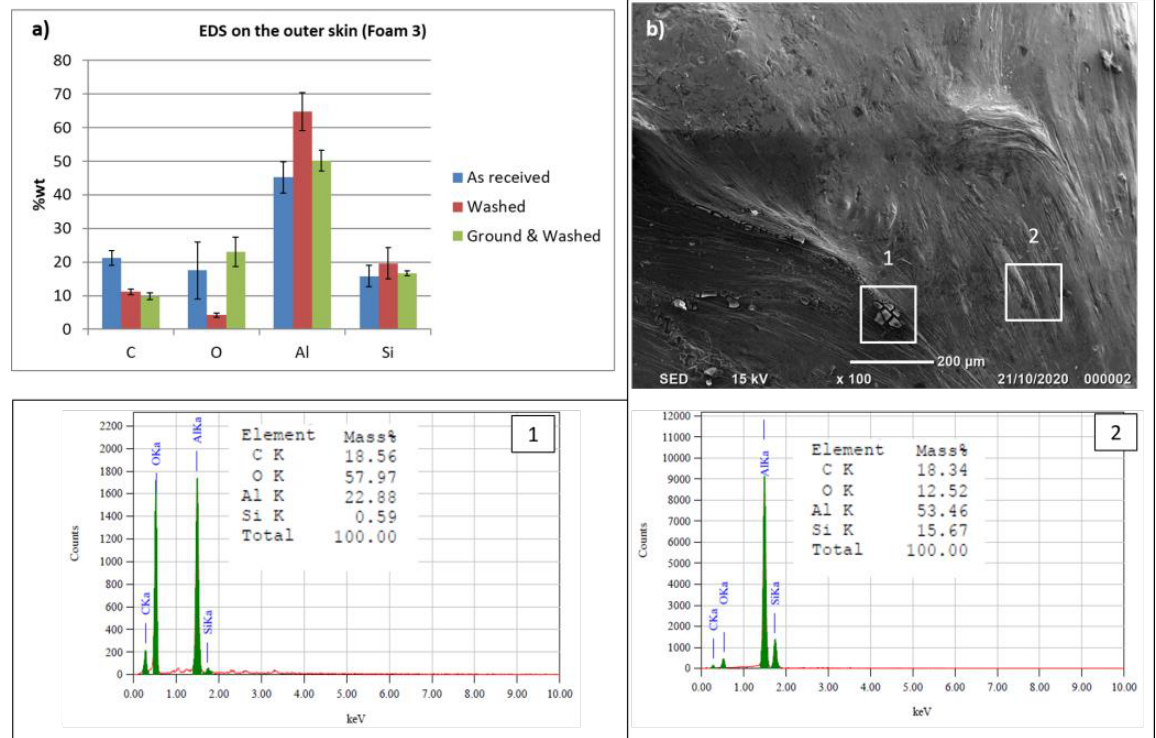
Figure 5. ( a ) EDS analyses on the outer skin of foam 3 (as example) after different surface preparations (as received, washed, ground and washed), ( b ) SEM-EDS analyses on specific point of the outer skin of the foam.